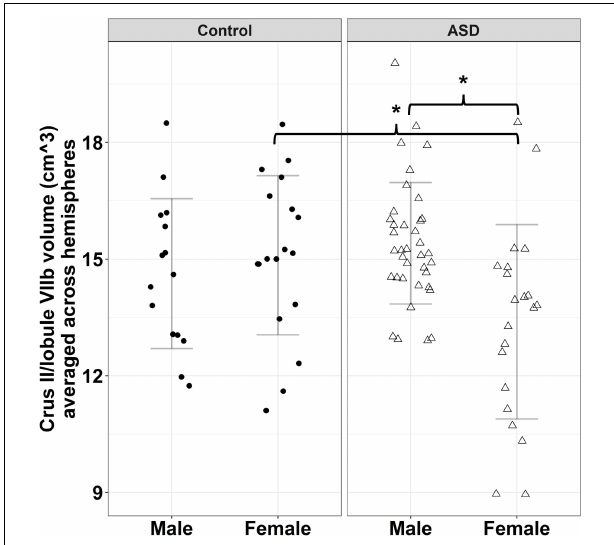
FIGURE 3 | Sex-dependent group differences in Crus II/lobule VIIB volume. Error bars reflect mean ± 1 SD. * denotes p < 0.05.